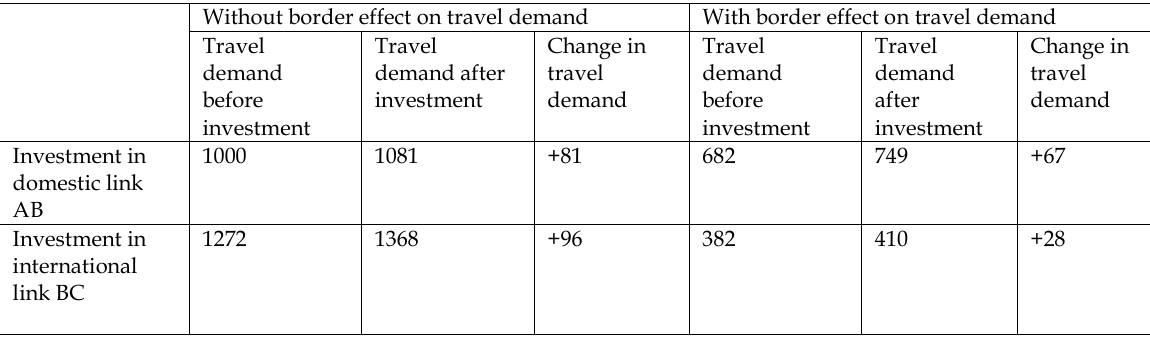
Table 4. Travel demand effects of investing in domestic versus international links, with and without border